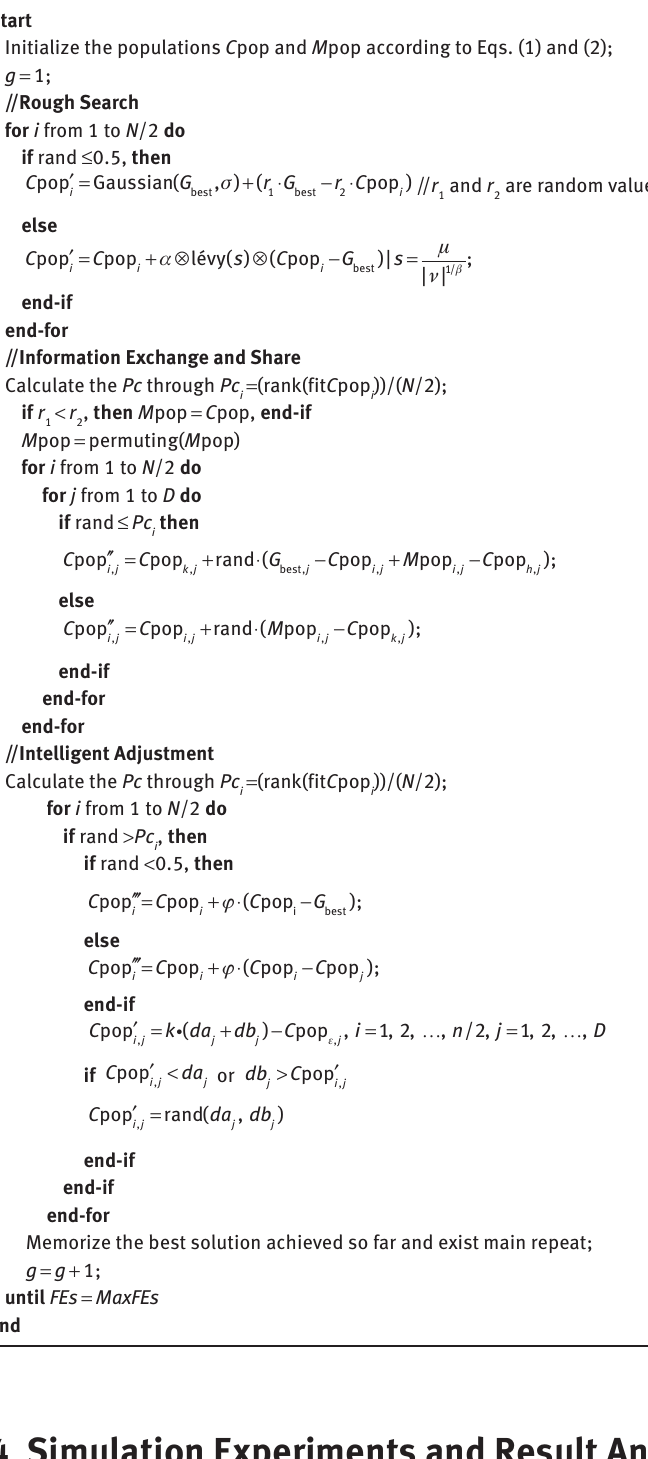
Algorithm 2: Pseudo-code of the